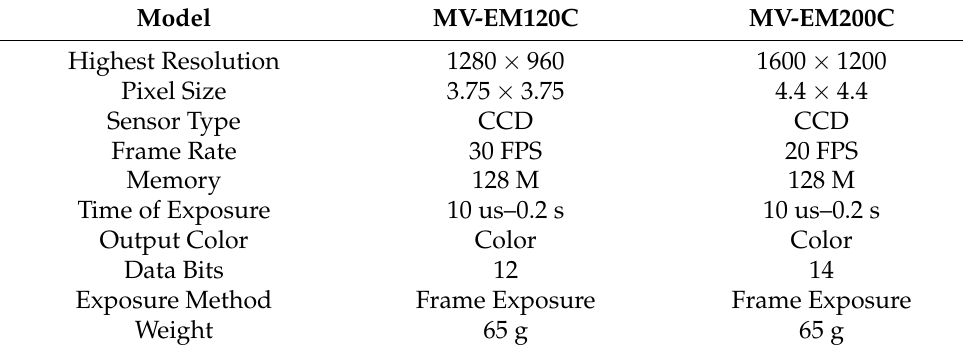
Table 1. Compared with MV-EM120C and